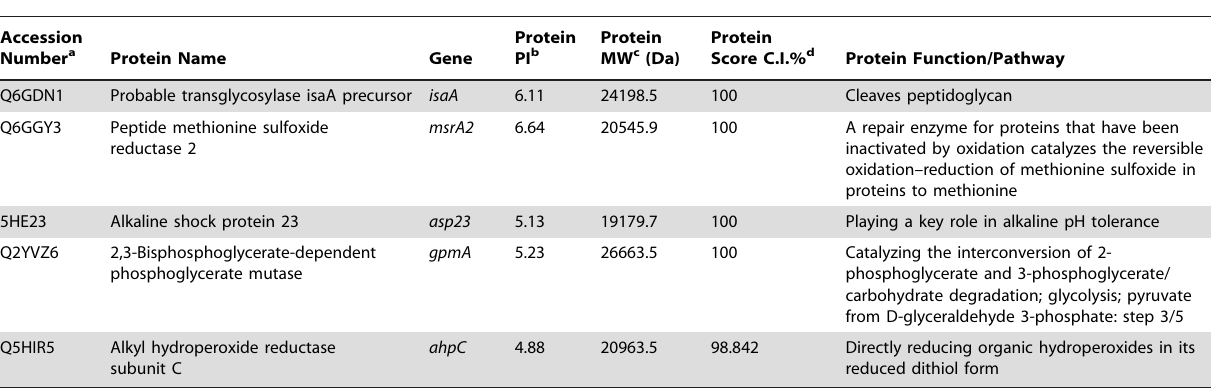
Table 3. Proteins differentially expressed between hVISA and VSSA identified in this